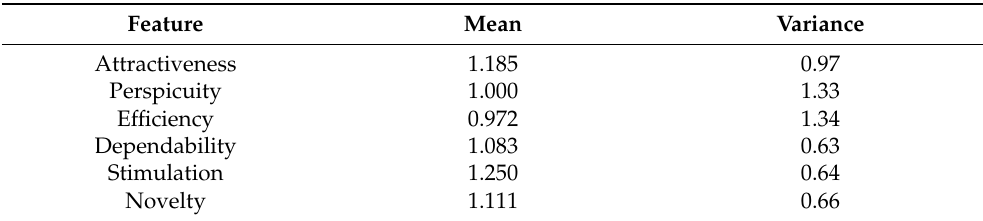
Table 4. Second training course—UEQ scales (mean and